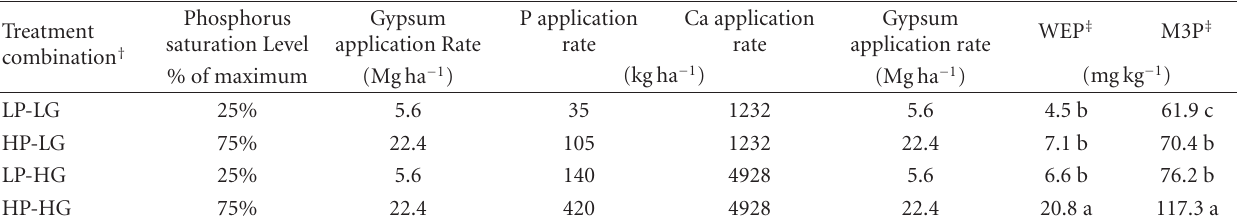
Table 2: Treatments resulting from combination of phosphorus saturation level (expressed as a percent of the isotherm maximum) and gypsum application rate and the resulting application rates of phosphorus (P) and calcium (Ca), and their e ff ect on soil water extractable P (WEP) and Mehlich 3 P (M3P) concentrations, averaged across time and soil